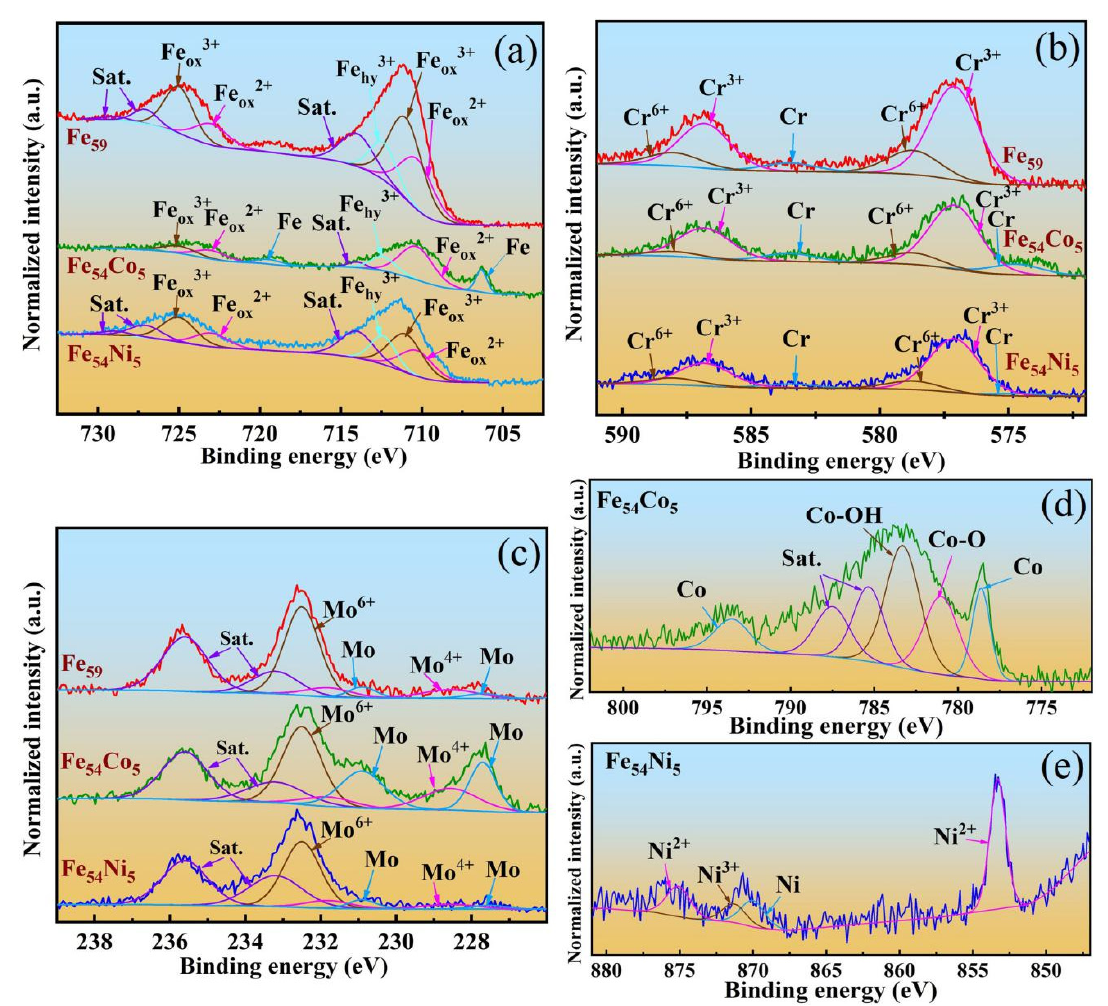
Figure 4. XPS spectra of Fe 2p ( a ), Cr 2p ( b ), Mo 3d ( c ), Co 2p ( d ), and Ni 2p ( e ) in the passive films on the surface of the Fe 54 M 5 Cr 15 Mo 6 Si 2 B 4 P 10 C 4 (M = Fe, Co, and Ni) glassy alloy rod specimens after electrochemical measurements in a 3.5 wt.% NaCl solution.